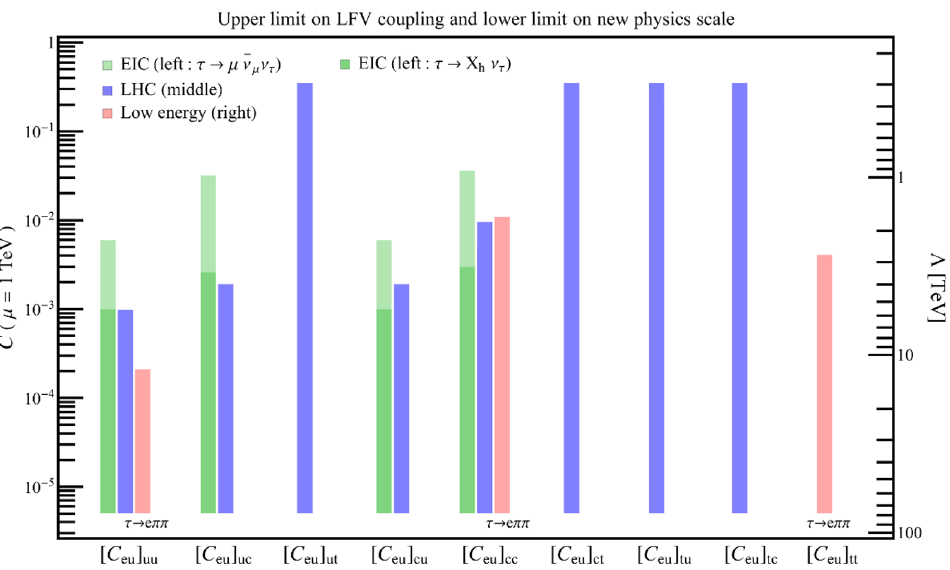
Figure 18 . Upper limit on C eu (leftmost axis) and lower limit on new physics scale Λ (rightmost axis). For the EIC expected sensitivity, the light green bar corresponds to the result in table 7, while the dark green one represents the case in hadronic tau decay mode assuming (cid:15) n b = 0 in tables